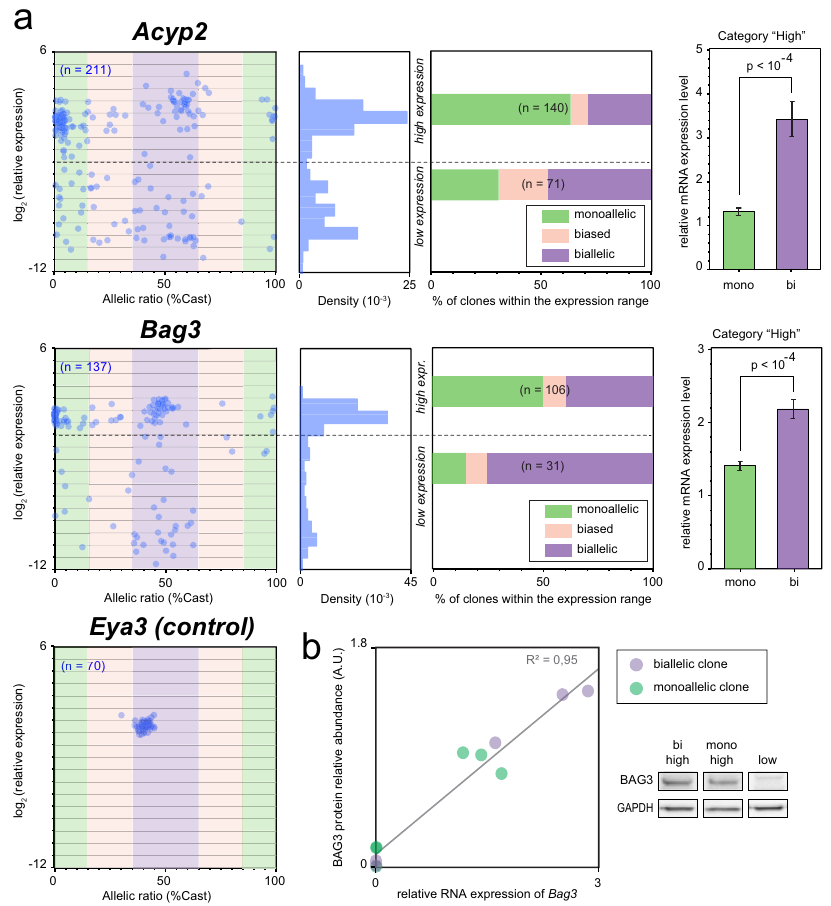
Fig. 5 Random monoallelic expression is associated with reduced gene dosage. a Comparison of the allelic expression ratio and mRNA expression levels in NPC clones (measured by qPCR), for Acyp2 , Bag3 and Eya3 ( n is the number of clones analysed for each gene; left panels). The density histograms show the distribution of expression levels; the dashed lines indicate the threshold used to categorise high or low expressing clones (middle left panels). Proportion of clones in each allelic category for clones showing high or low expression levels (middle right); allelic categories: monoallelic [ratio < 15% or >85%], biased [ratio 15 – 35% or 65 – 85%], biallelic [ratio 35 – 65%]; n is the total number of clones. mRNA levels in monoallelic clones compared to biallelic clones (excluding the clones with low expression levels – right panels). Data were means ± SEM; two-tailed unpaired t -tests, Acyp2 t = 6.5 df = 131, Bag3 t = 5.6 df = 92. b BAG3 relative protein levels measured by western blot (normalised to GAPDH levels), compared to the relative RNA abundance measured by RT-qPCR, for a selection of 11 NPC clones. Linear regression F (1,9) = 176, p < 10 − 4 . A western blot image of the Bag3 full-length form is shown for three representative NPC clones. Full original blot images are provided in Supplementary Fig.